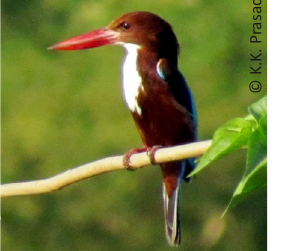
Image 40. Pied-crested Cuckoo Clamator jacobinus